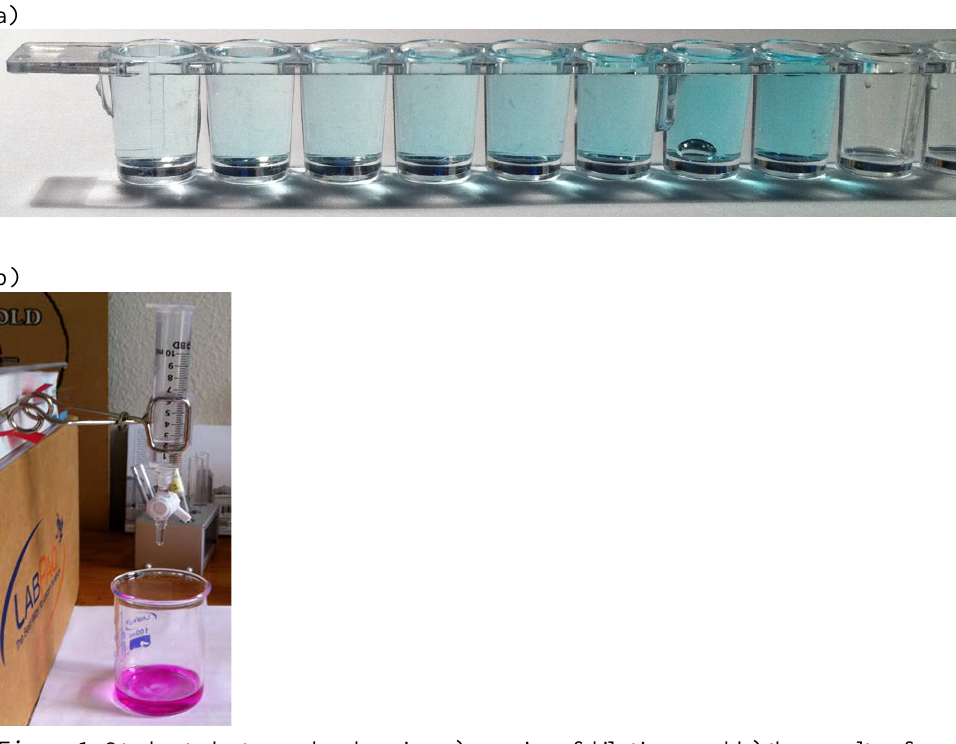
Figure 1. Student photographs showing a) a series of dilutions and b) the results of a